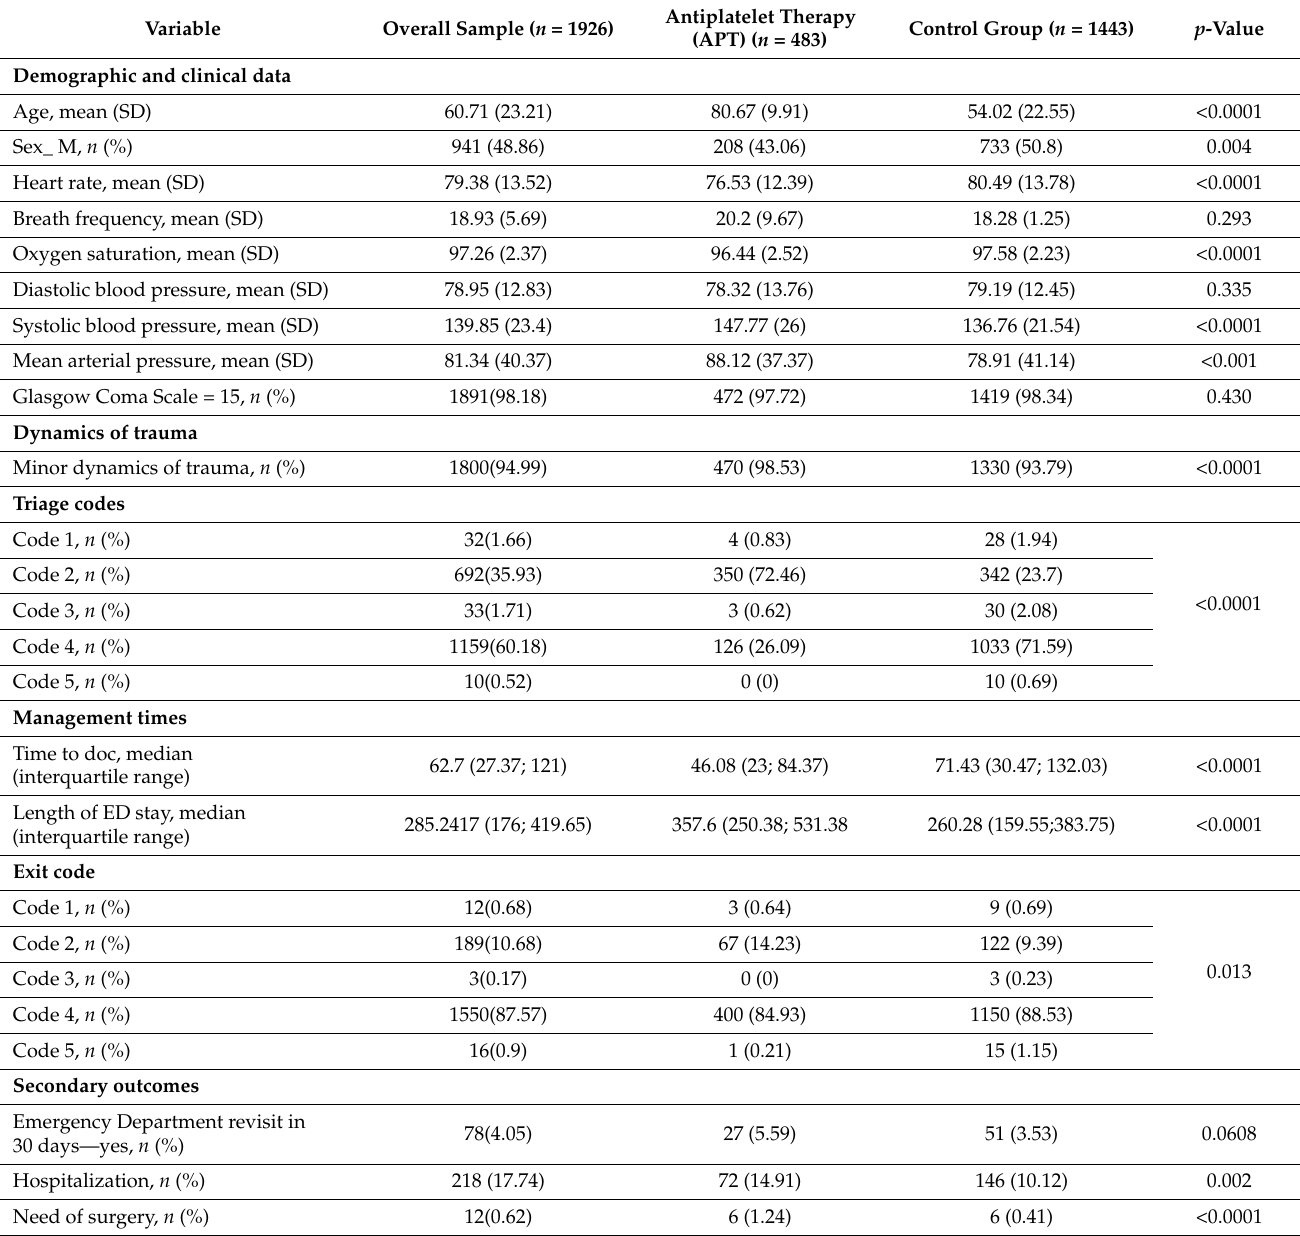
Table 1. Descriptive statistics for overall sample and distinctly per